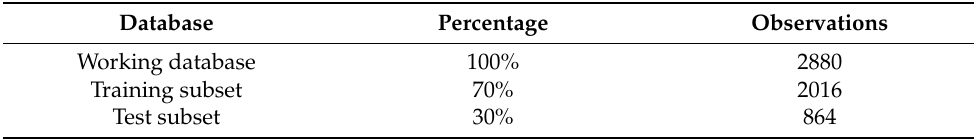
Table 4. Partition of the data.